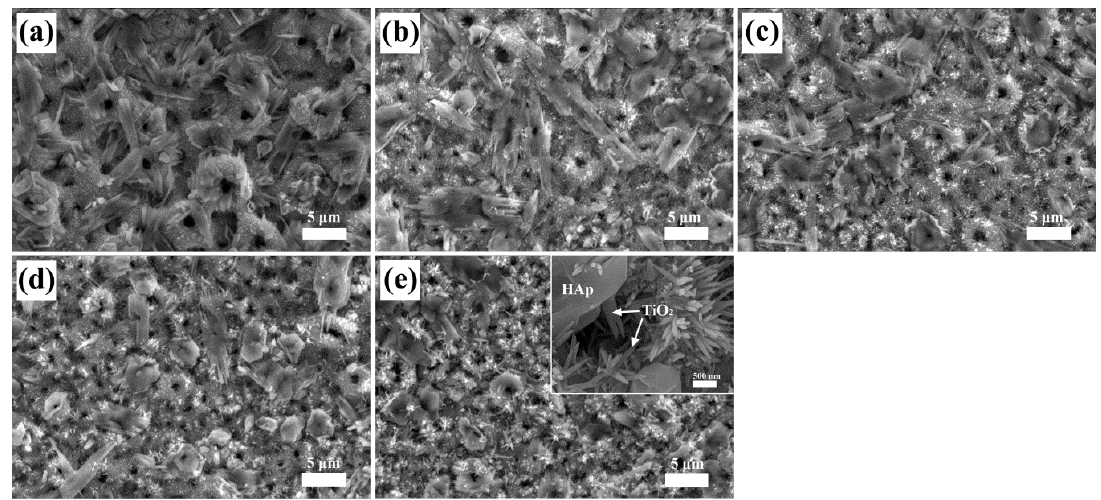
Figure 4. SEM images of MAO/HT ‐ treated samples. ( a ): cp ‐ Ti; ( b ): Ti ‐ 5Fe; ( c ): Ti ‐ 5Mo; ( d ): Ti ‐ 5V; ( e ): Ti ‐ 5Zr.